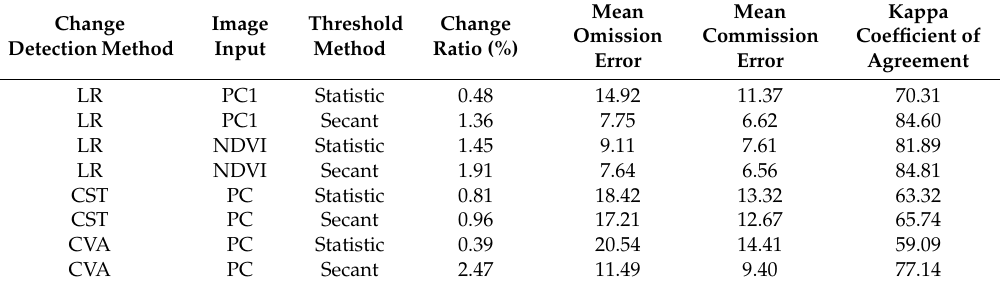
Table 3. Omission/commission error and the kappa coefficient of agreement, obtained for each landslide map.